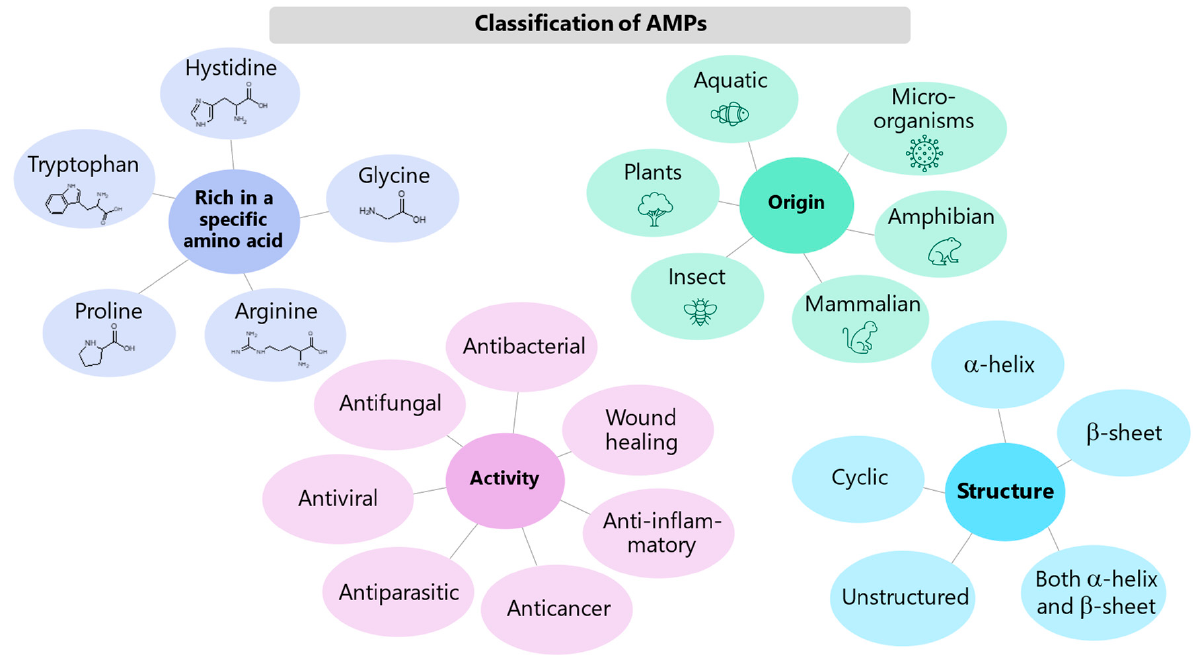
Figure 2. Classification of AMPs.